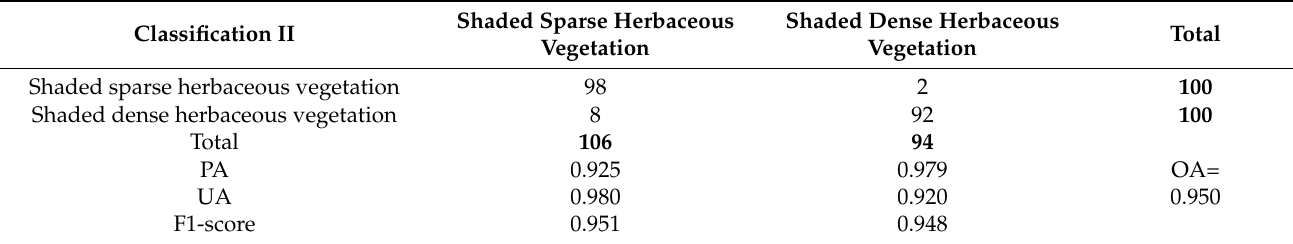
Table 5. Error matrix of classification II. PA = Producer’s Accuracy; UA = User’s Accuracy; OA = Overall Accuracy. Shaded Sparse Herbaceous Shaded Dense Herbaceous Classification II Total Vegetation Vegetation Shaded sparse herbaceous vegetation 98 2 100 Shaded dense herbaceous